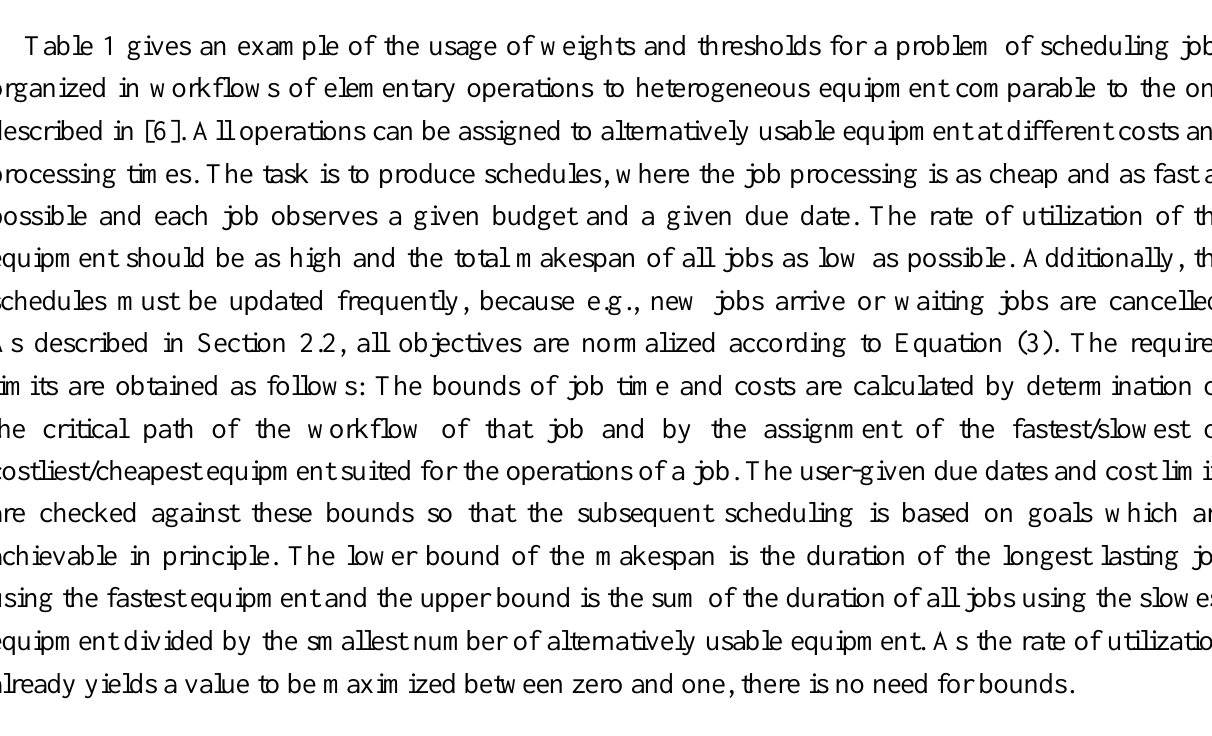
Table 1. Example of the use of the cascaded weighted sum (CWS) and the effect of objective group weights. The objectives with the highest priority are always active and contribute to the weighted sum. They are marked here by a light green